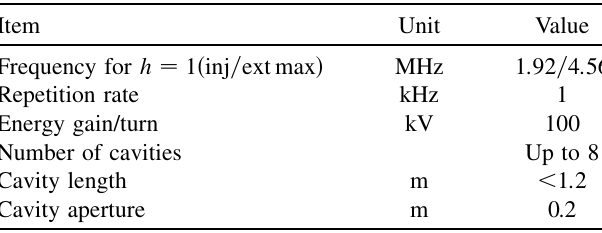
TABLE IX. Requirements of PAMELA rf